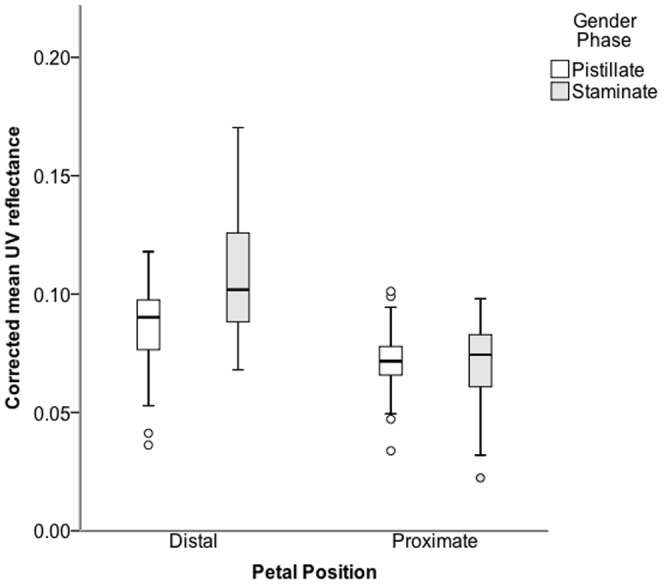
Possible UV nectar guides in S. officinalis.Differences in the UV reflectance at proximal and distal ends of petals of S. officinalis in staminate- and pistillate-stage flowers. Boxes represent the median and quartile ranges for each variable. Open circles represent values that lie between 1.5 and 3 box lengths from the end of the box. The average percentage of light reflectance in the UV range was corrected for overall amount of light reflected over the entire spectrum (see Methods).